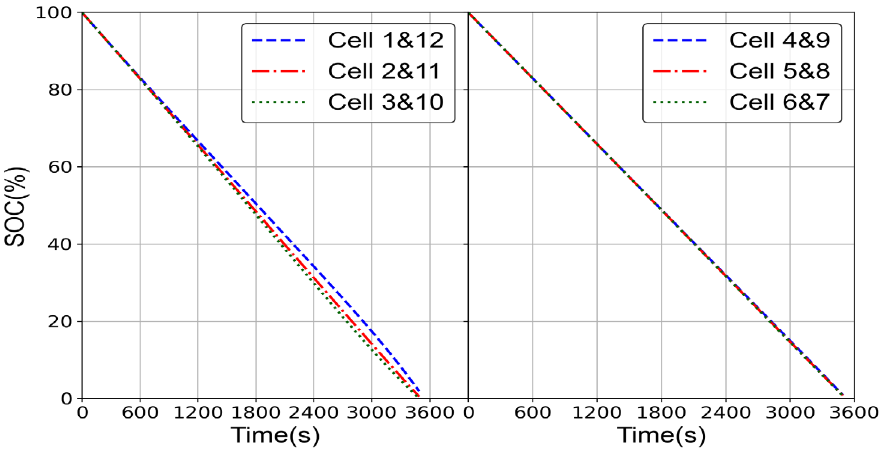
Figure 13. SOC of cells under the inhomogeneous cooling case 13.